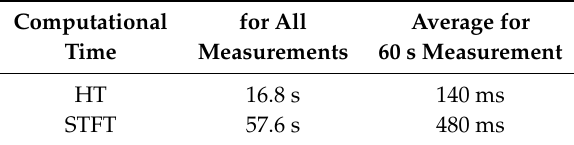
Table 8. Comparison of the computational effort for Hilbert transform (HT) and STFT. Computational for